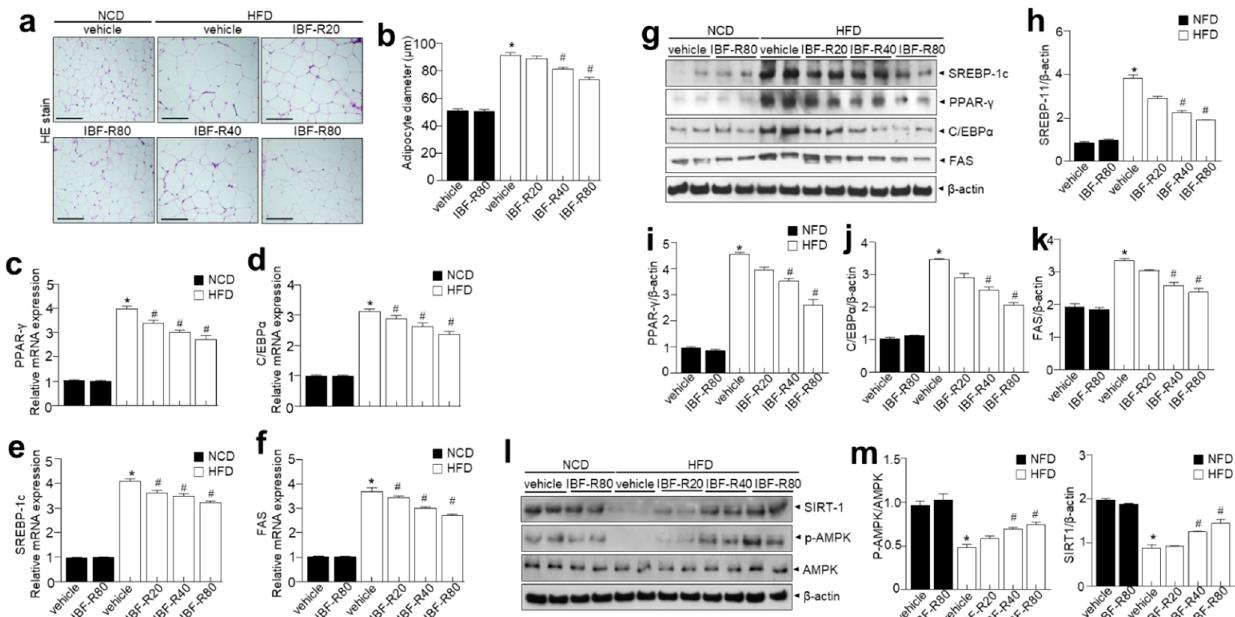
Figure 4. IBF-R determines adipose tissue expansion and adipogenic factors in eWAT. ( a ) H&E staining in eWAT. Scale bar = 50 µm. ( b ) The mean diameter of adipocytes in eWAT. ( c – f ) C/EBP α , PPAR- γ , FAS and SREBP-1c were measured in eWAT by qRT-PCR. ( g ) Immunoblotting of PPAR- γ , C/EBP α , SREBP-1c, FAS, and β -actin expressions in eWAT. ( h – k ) Quantification of protein expressions. ( l , m ) Immunoblotting of p-AMPK, AMPK, SIRT-1, and β -actin expressions in eWAT and respective quantitative analysis. Data are shown as mean ± SEM ( n = 10, * p < 0.05 vs. NCD + vehicle, # p < 0.05 vs. HFD + vehicle). eWAT; epididymal white adipose tissue.